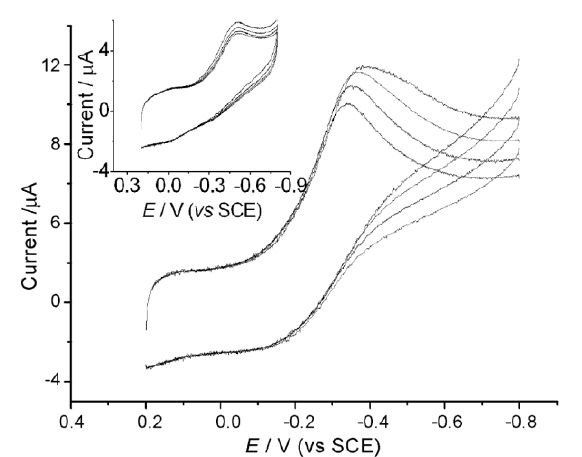
Figure 4. Cyclic voltammograms of HRP–GOD/SBA-15 modified GCE in 0.1 M 7.0 PBS containing 0, 1.0, 2.0 and 3.0 mM glucose (from bottom to top) at 0.10 V/s. Inset: cyclic voltammograms of HRP–GOD modified GCE in 0.1 M 7.0 PBS containing 0, 1.0, 2.0 and 3.0 mM glucose (from bottom to top) at 0.10 V/s. Reprinted from reference [30] with permission from Elsevier Science B.V.